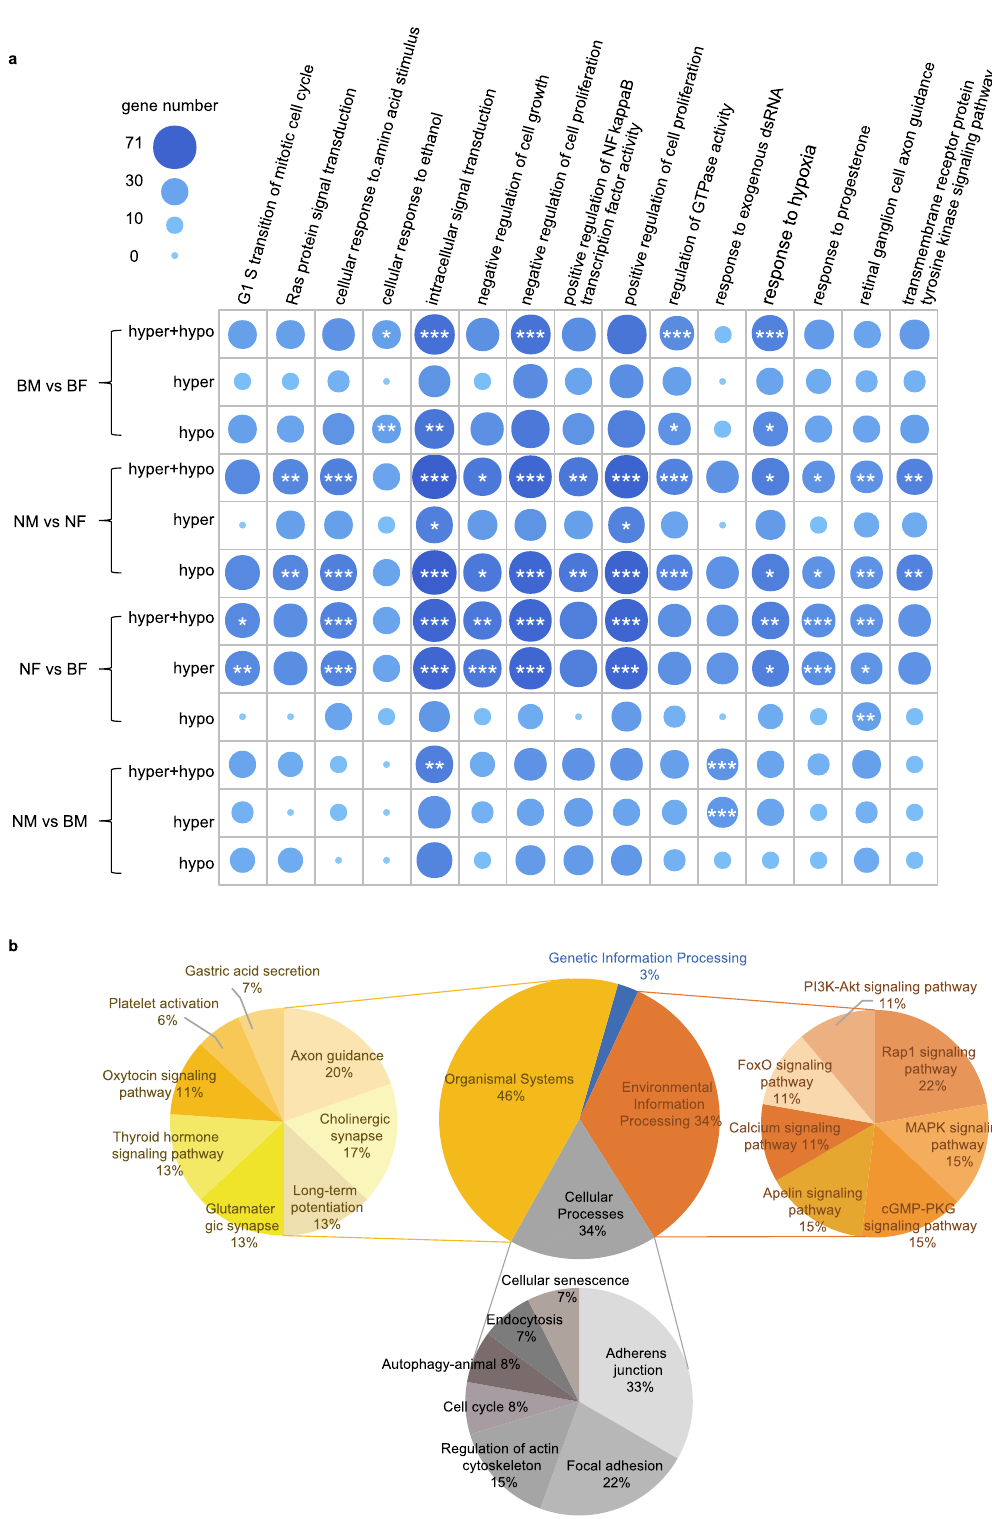
Figure 6. Functional enrichment for DMRs genes. ( a ) 15 enriched biological process GO terms of different methylation levels for normal tissue comparison (BM vs BF), tissue comparison induced by WEA (NM vs NF), effects of WEA on adipose (NF vs BF) and muscle (NM vs BM). *Adjusted p value < 0.05, **adjusted p value < 0.01, ***adjusted p value < 0.001. ( b ) Percentage of enriched KEGG pathways for different methylation levels for normal tissue comparison, tissue comparison induced by WEA, effects of WEA on adipose and